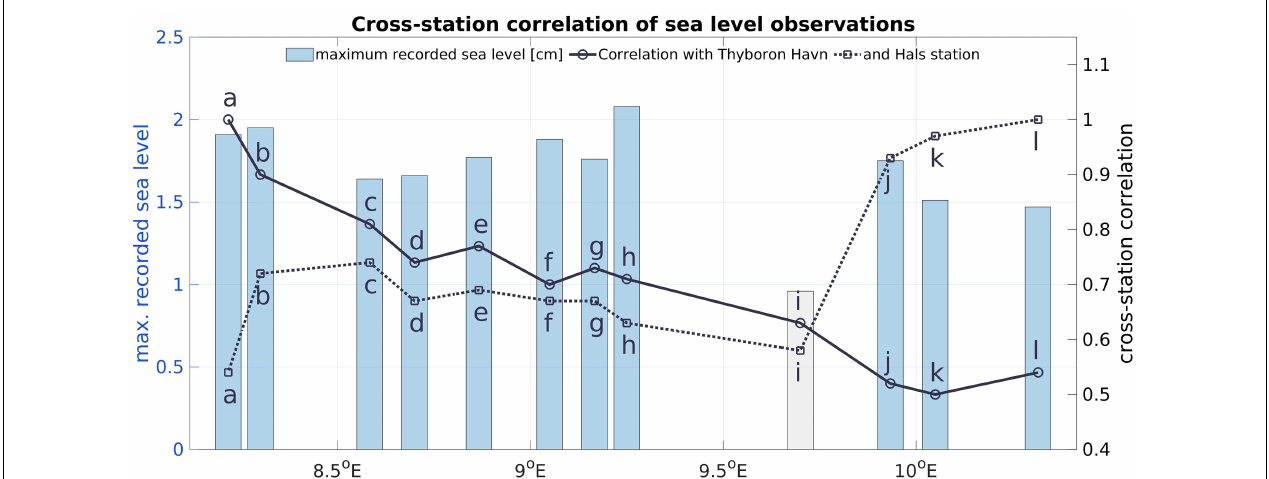
FIGURE 2 | Maximum recorded sea level at Limfjord stations (bars) and cross-station correlation coefficient (lines) of observed sea levels with the sea levels at the boundary stations Thyboron (full lines) and Hals (dotted lines). From west-to-east: (a) Thyboron, (b) Lemvig, (c) Struer, (d) Thisted, (e) Nykøbing Mors, (f) Skive, (g) Rønbjerg Huse, (h) Logstør, (i) Haverslev Havn, (j) Aalborg East, (k) Grønlandshavn and (l) Hals. Haverslev is a new station, which has been established in